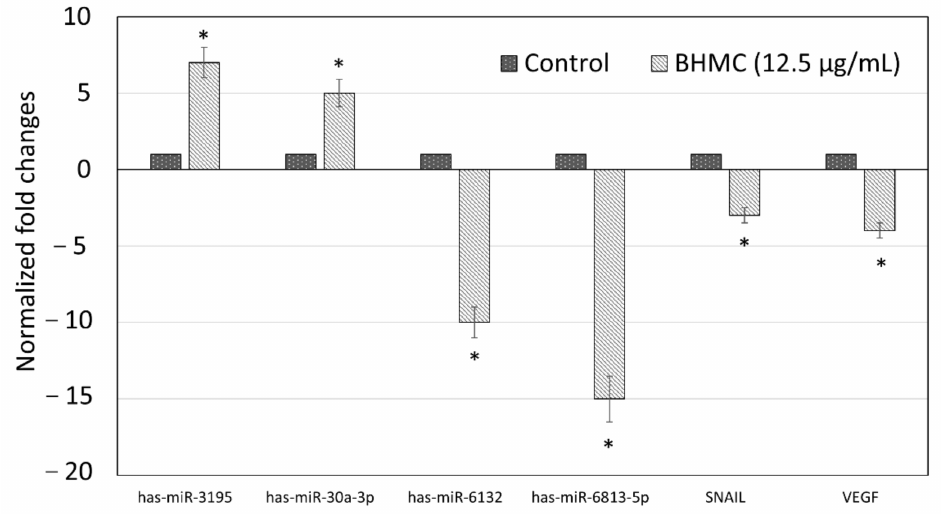
Figure 4. Validation of known miRNA and targeted genes using qPCR. Values are mean ± SD of three replicates and significantly different from the untreated group (* p < 0.05) by ANOVA and followed by Duncan’s multiple range test. Figures shown were representative of one of at least three independent replicates with similar parameter. Table 2. Top five up- and down-regulated miRNAs significantly altered in BHMC-treated MCF7 cell. Transcript